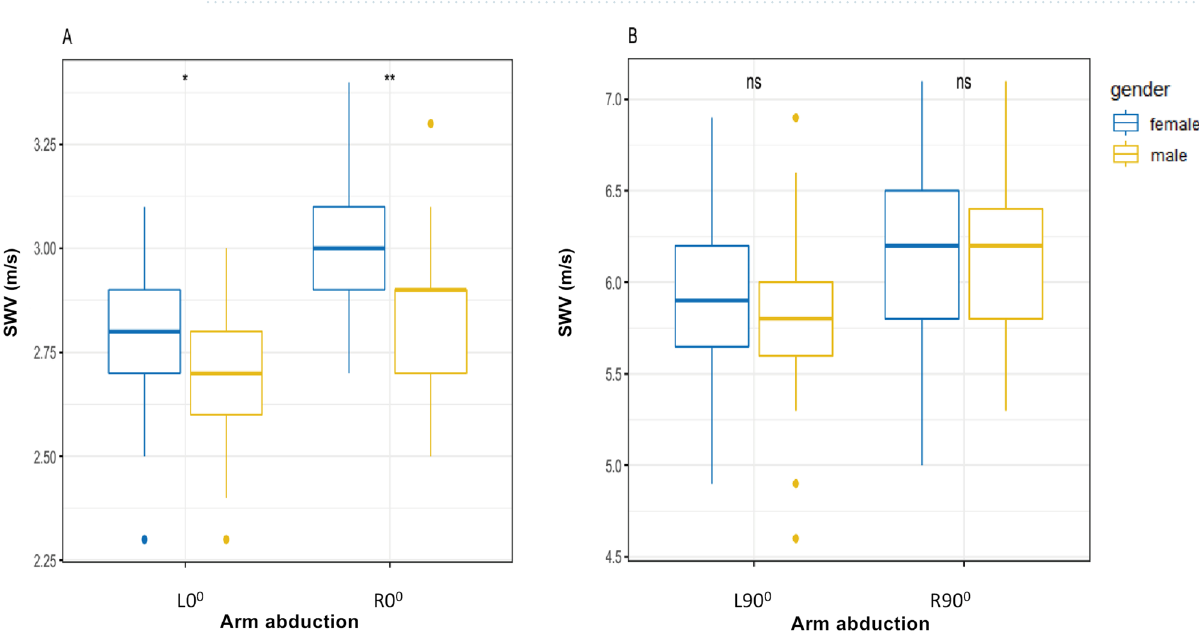
Figure 4. Box plots of the SWV in healthy participants between different gender at L0°, R0°, L90° and R90° respectively. ( A ) Difference of the SWV between female and male at L0° and R0°; ( B ) Difference of the SWV between females and males at L90° and R90°; ns, no significance; * p < .05; ** p < .01. SWV mean shear wave